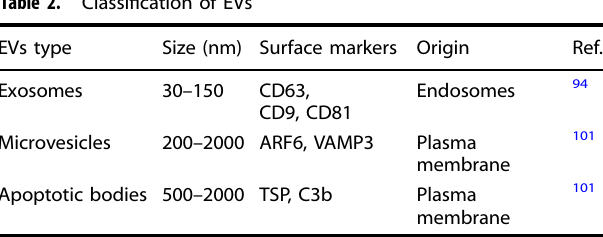
Table 2. Classi fi cation of EVs EVs type Size (nm) Surface markers Origin